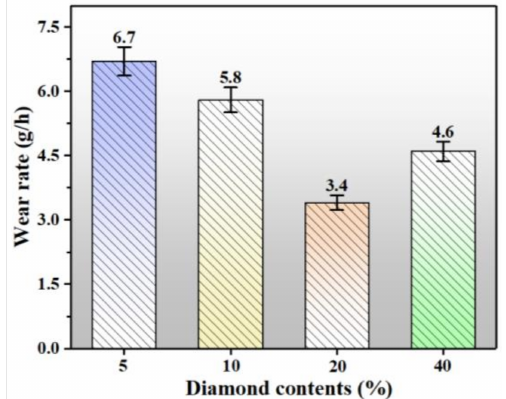
Figure 20. Wear rate of the samples with different diamond